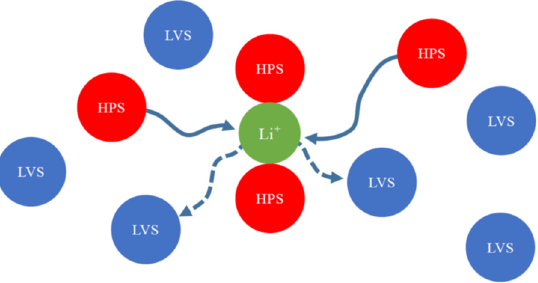
Figure 11. A schematic of a molecular configuration of the selective solvation (LVS means a solvent molecule with low viscosity, HPS means a solvent molecule with high permittivity).